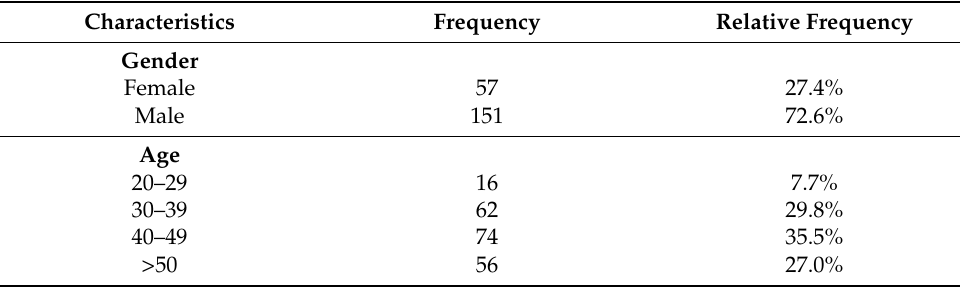
Table 2. Descriptive statistics of respondents’